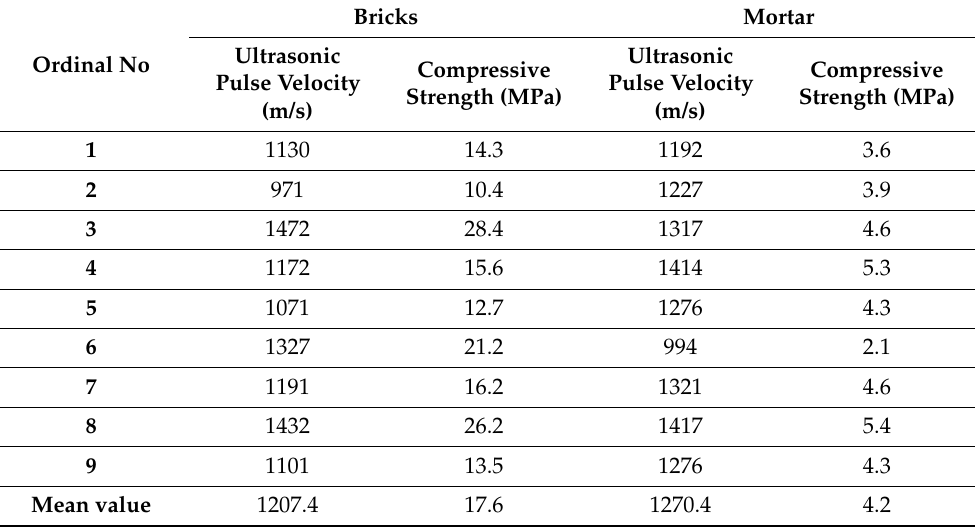
Table 1. Ultrasonic pulse velocity and calculated compressive strength of tested bricks and mortar. Bricks Ordinal No